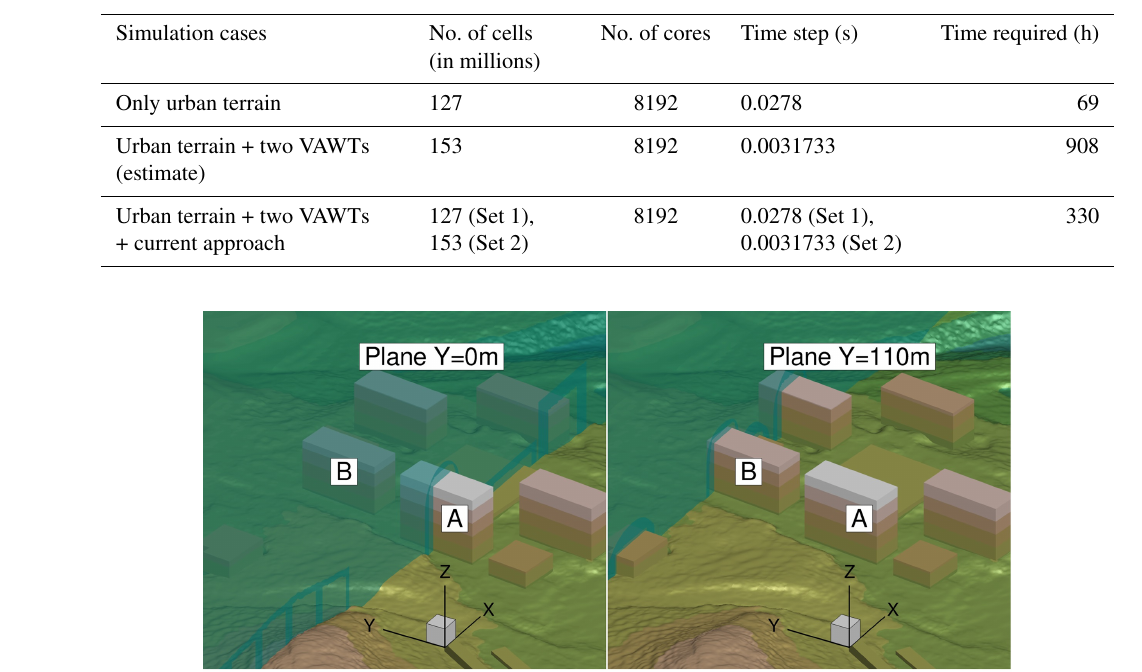
Figure 6. Post-processing planes passing through A and B.